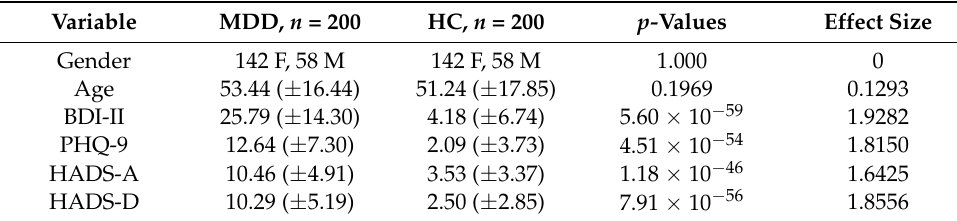
Table 1. Demographic data and results of